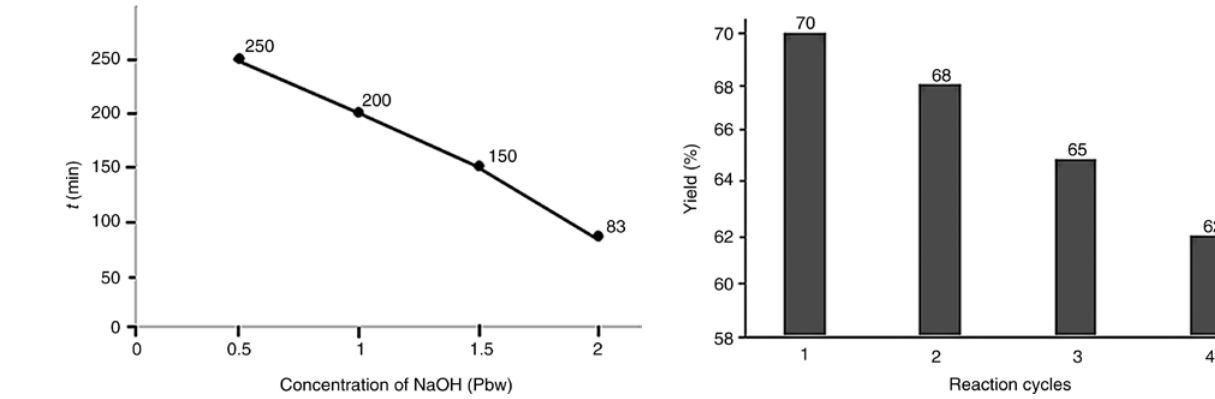
Scheme 2: The effect of alkali metal catalyst concentration in Scheme 4: The effect of reuse of nano-TiO